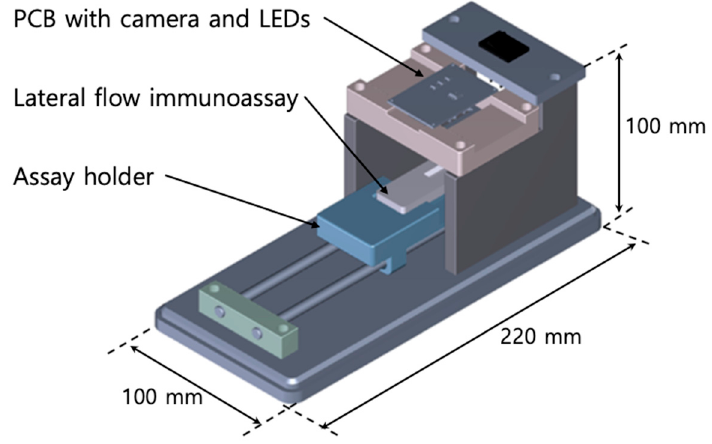
Figure 2. An assay reader for the quantitative analysis using a color camera. The assay reader consists of a camera, LEDs, a holder onto which the assay is mounted, and rails for transport. There is a cover for separation from ambient light, but it is not shown in the figure. PCB = printed circuit board.